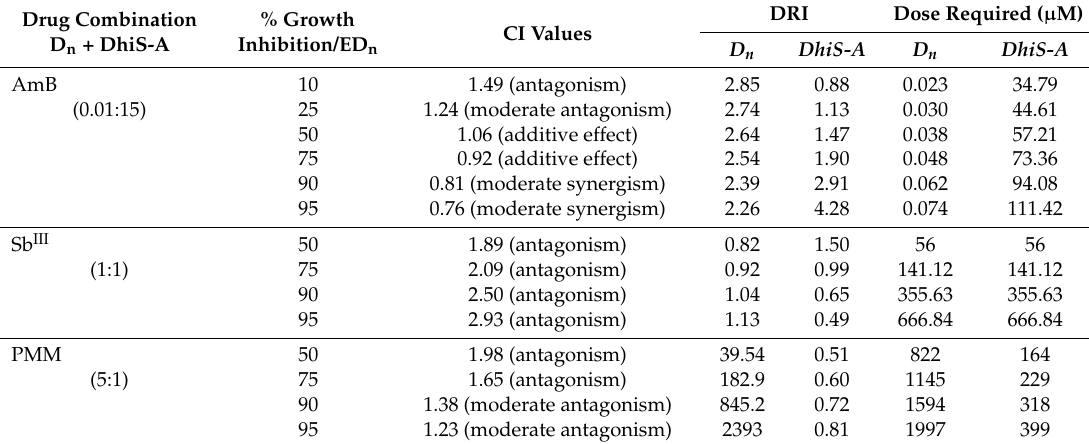
Table 1. Dose–effect relationship of the combination of antileishmanial drugs (Dn) and dehydroisosilybin A (DhiS-A) on Li promastigotes 1 .